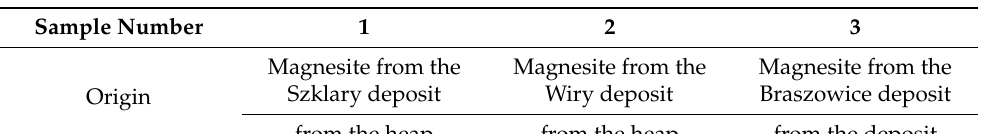
Table 1. List of magnesites used for the evaluation of sorption properties in relation to SO 2 in the conditions of fluid combustion technology.